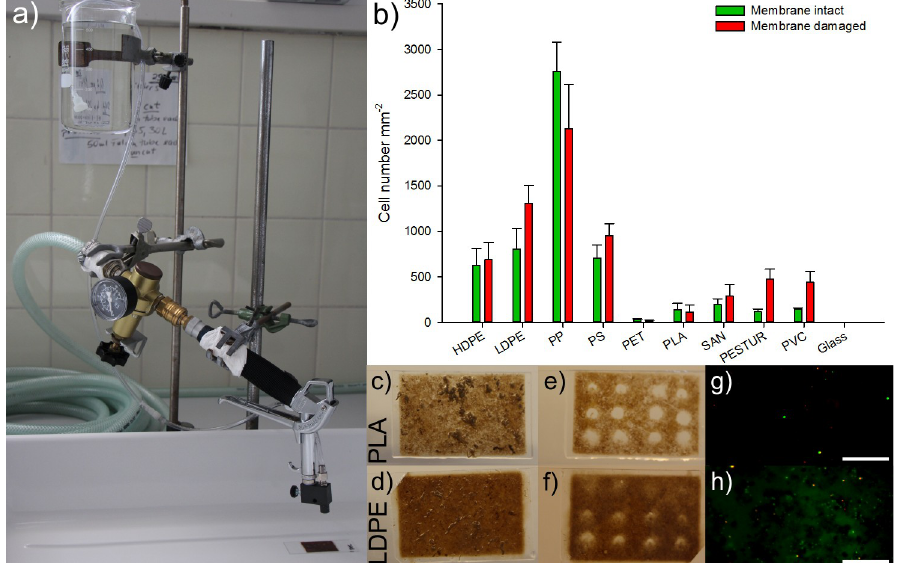
Fig 2. High-pressure water Jet treatment with the a) high pressure treatment device. b) Barplot of the enumerated mean of adherent membrane intact (green) and membrane damaged (red) cells after a high pressure treatment at 4 bar for 2 minutes, vertical bars denote the Standard Error. Photograph of the 21 month old biofilm attached to c) Polylactic acid and d) Low density polyethylene. Resulting spots e; f) in respective biofilms after high pressure treatment. Double stained (SYBR Green & PI) cells on respective substrate g; h) after high pressure treatment with, scale bars are 10 μ m.